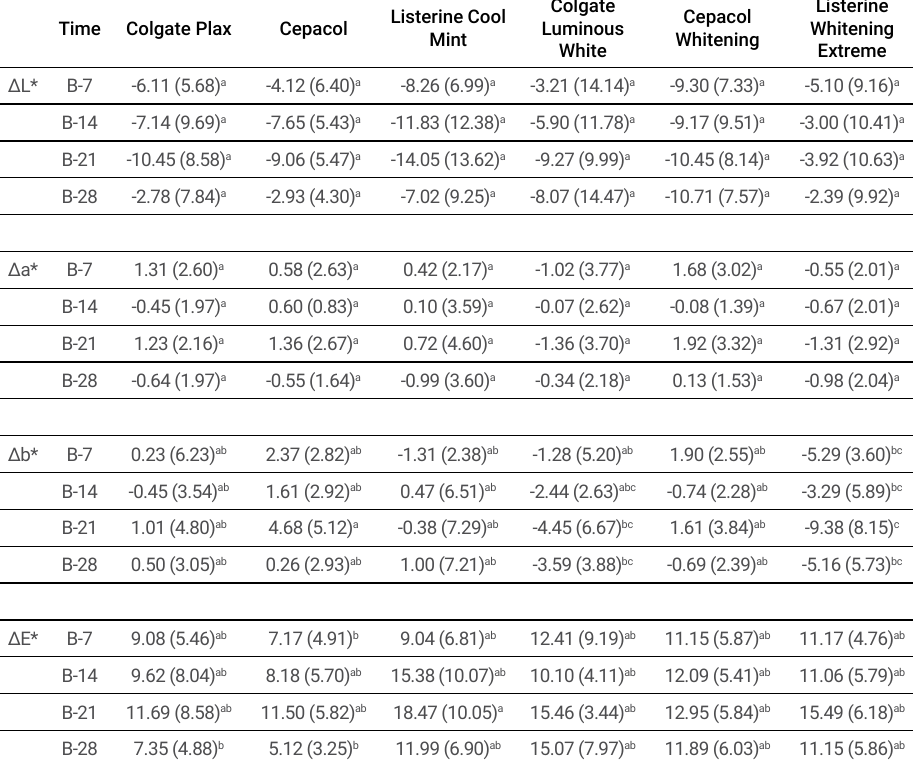
Table 2. Results of Δ L*, Δ a*, Δ b* and Δ E* (mean and SD) for each assessment interval